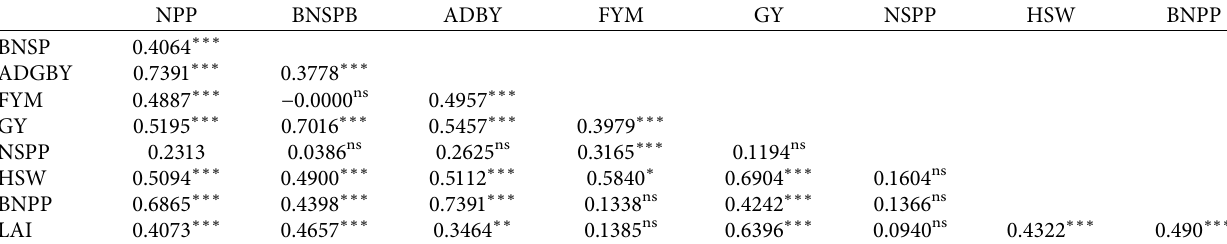
Table 7: Correlation coefcient ( r ) values and probability levels for blended NPSB fertilizer, farmyard manure, yield, and yield attributing traits as infuenced by blended NPSB and farm yard manure at Alle Special